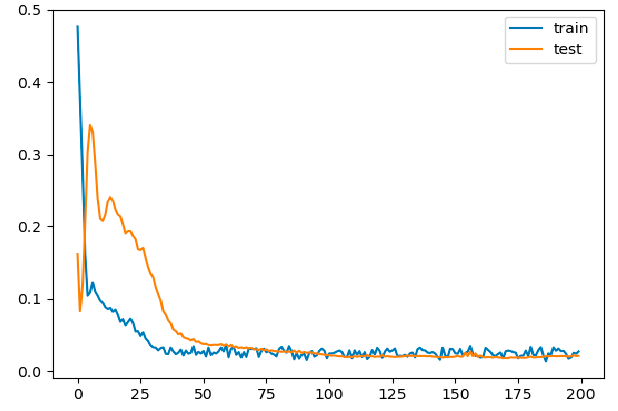
Figure 5. Training loss and testing loss of GRU.